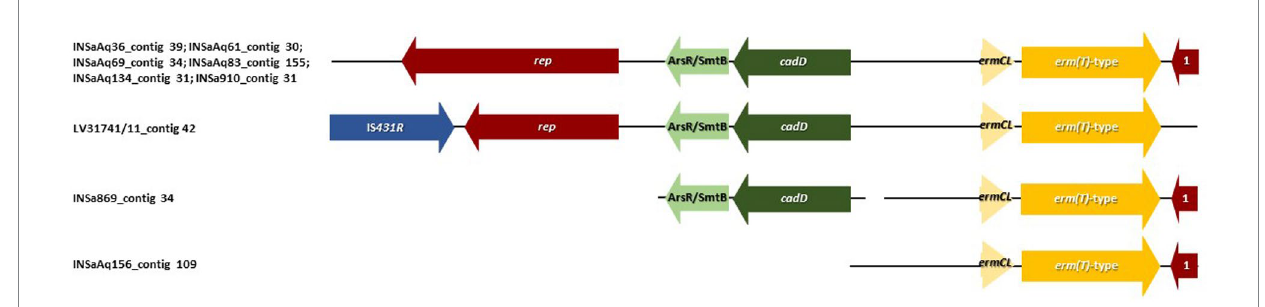
FIGURE 3 Genetic environment of erm(T) -type gene found in 9 out of 10 S. aureus ST398 strains (see Table 1: the exception was INSa934 isolated in humans). Arrows are drawn to scale. Genes in blue are associated with mobile genetic elements. Genes in red are associated with replication. Genes in green with tolerance to heavy metals. Genes in yellow are related with antibiotic resistance. 1-Truncated replication protein for plasmid. erm(T) -type genes had the same genetic environment in all strains, being the only distinct feature encountered in S. aureus ST398 recovered from one dolphin (LV31741/11) that presented an IS 431R upstream the rep gene.